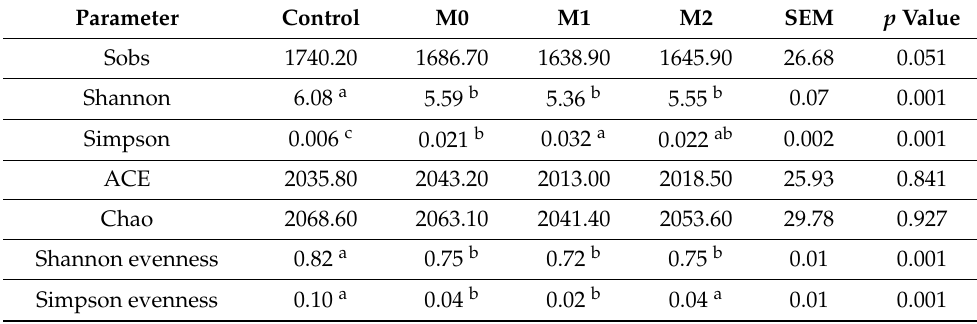
Table 7. Alpha diversity parameters across different treatment groups.